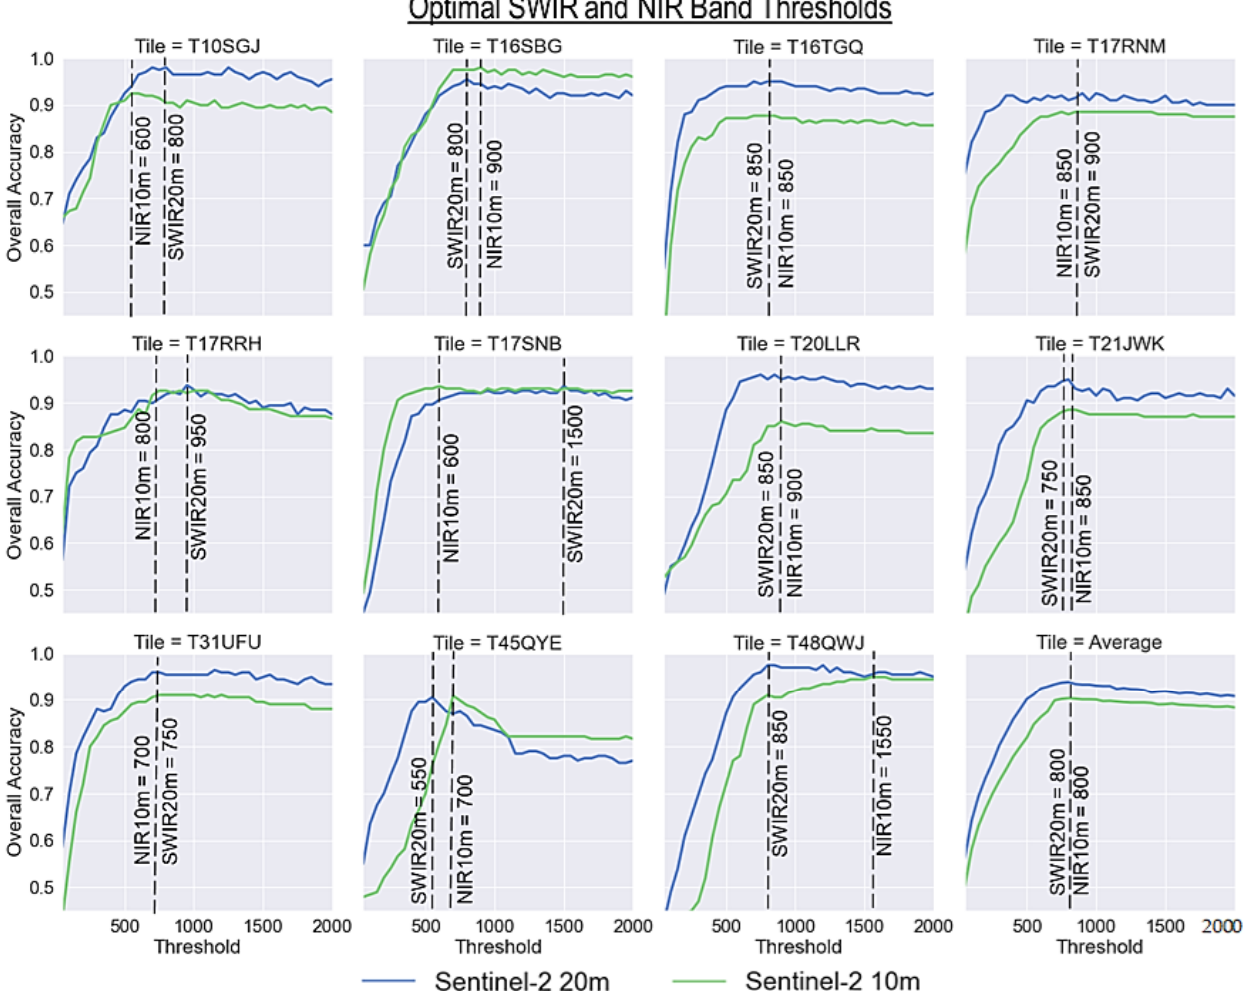
Figure 4. Evaluation of the most accurate band threshold for the 10 m and 20 m datasets across the test sites. For the 10 m dataset, the NIR band is used (due to lack of SWIR), and for 20 m dataset, the SWIR1 band is used. Overall accuracy improves significantly (>90%) when a band threshold is applied as compared with no threshold in the previous